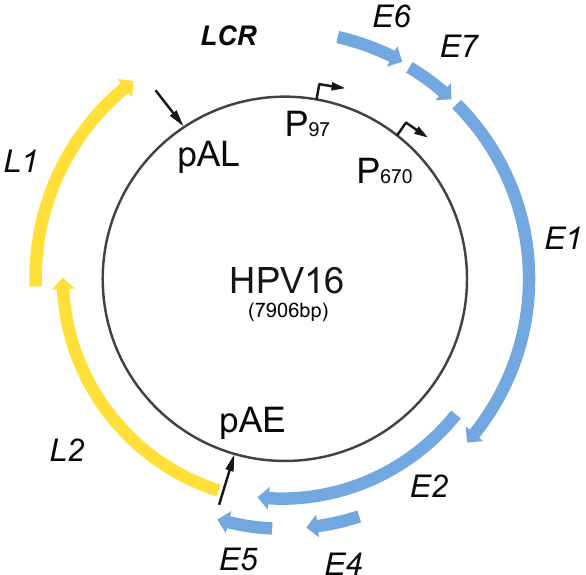
Figure 1. Schematic representation of human papillomavirus type 16 (HPV16) genome. The HPV16 genome is a circular double-stranded DNA molecule of eight kilobases. Blue cylinders represent HPV16 early genes (E1, E2, E4, E5, E6, and E7), and yellow cylinders represent HPV16 late genes (L1 and L2). HPV16 early and late promoters P97 and P670, respectively, and HPV16 early and late polyadenylation signals pAE and pAL, respectively, are indicated. The long control region (LCR) situated between the L1 stop codon and the E6 start codon contains the origin of DNA replication and the HPV16 early promoter / enhancer